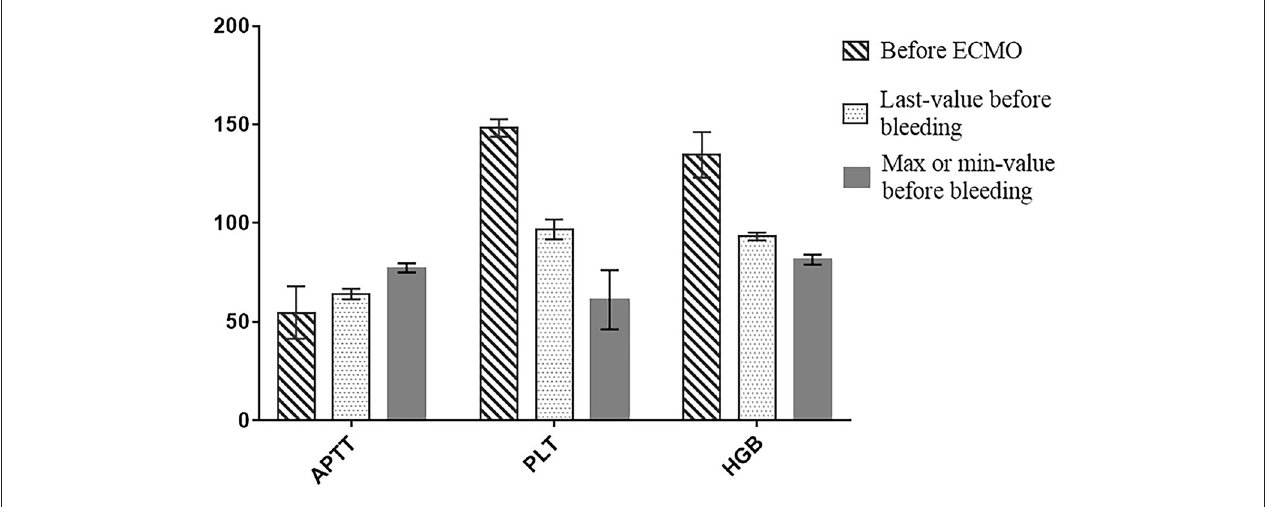
FIGURE 3 | Column diagram of APTT, PLT and HGB.